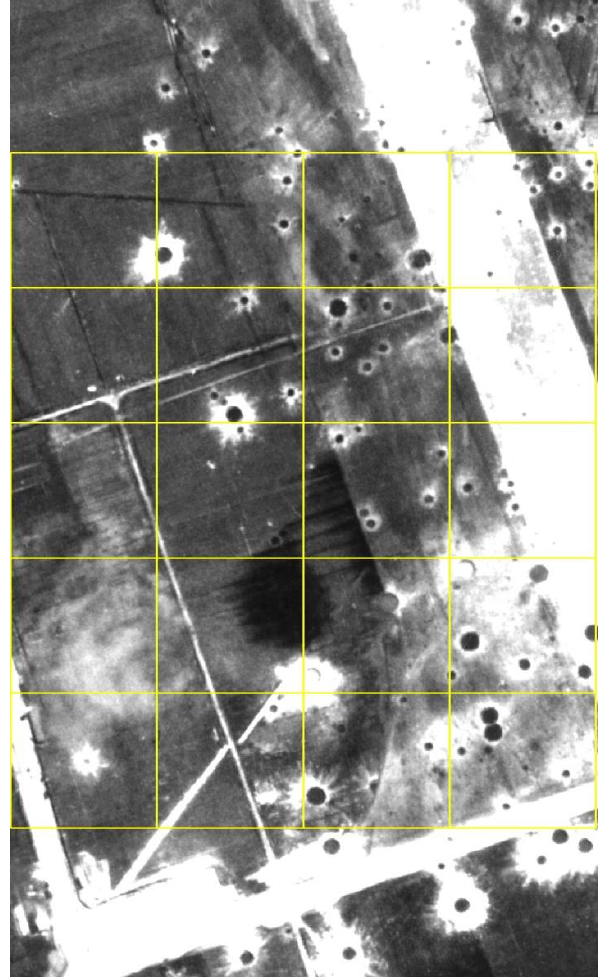
Figure 4. the same area of Figure 3 with 100 meter raster. The spatial precision is reduced and the large parcels cover inhomogeneous surface. The impact of the known craters on the statistics is distributed over a large parcel resulting in underestimation of the risk for a part of a parcel. The last column of the Table 2 contains the values for division